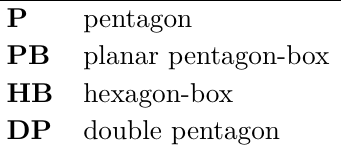
Table 4. The abbreviations for the Feynman integral topologies shown in figure 1, which are used by the interface of PentagonMI